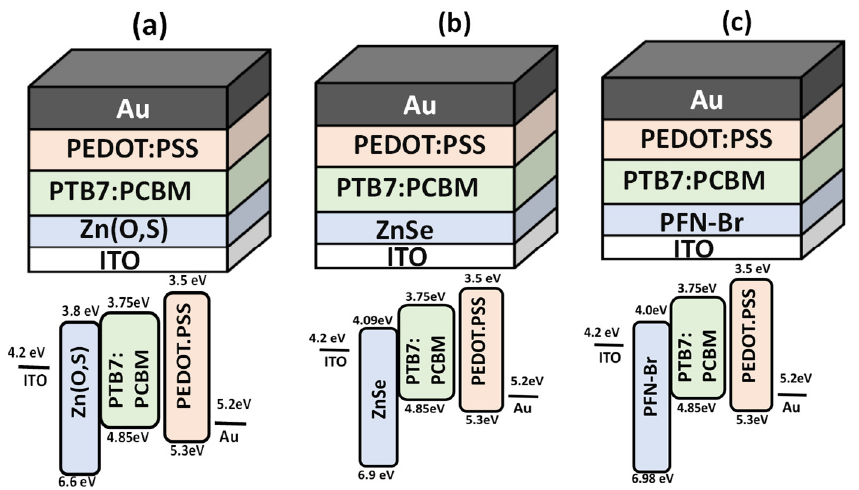
Figure 1. The device block structure and energy band diagram for ( a ) ITO/Zn(O,S)/PTB7:PC 70 BM/PEDOT:PSS/Au, ( b ) ITO/ZnSe/PTB7:PC 70 BM/PEDOT:PSS/Au, ( c ) ITO/PFN-Br/PTB7:PC 70 BM/PEDOT:PSS/Au.